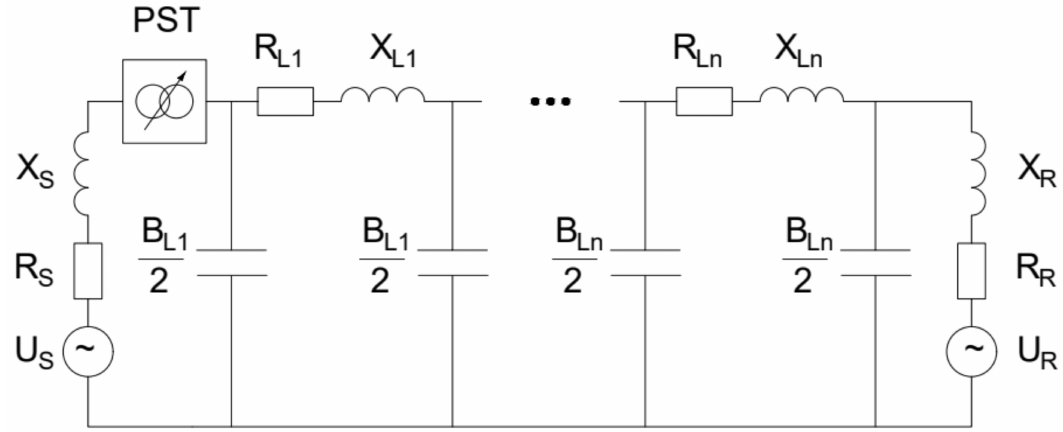
Figure 9. Laboratory arrangement with PST, distributed π -transmission line and power systems